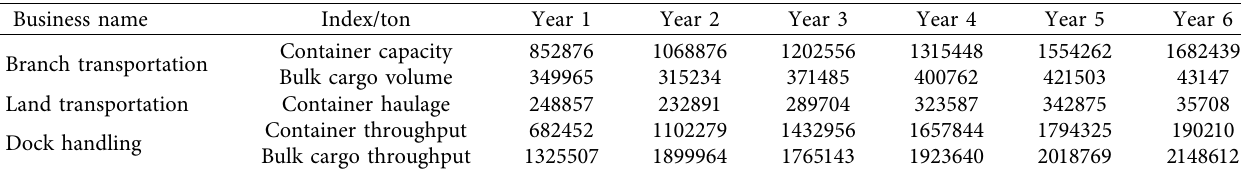
Table 8: Operational data of logistics enterprises at Dubai port.